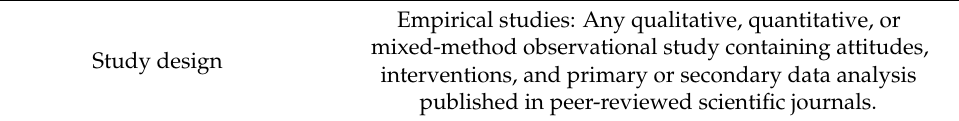
Table 2. Criteria agreed upon by the authors for the inclusion of studies in the